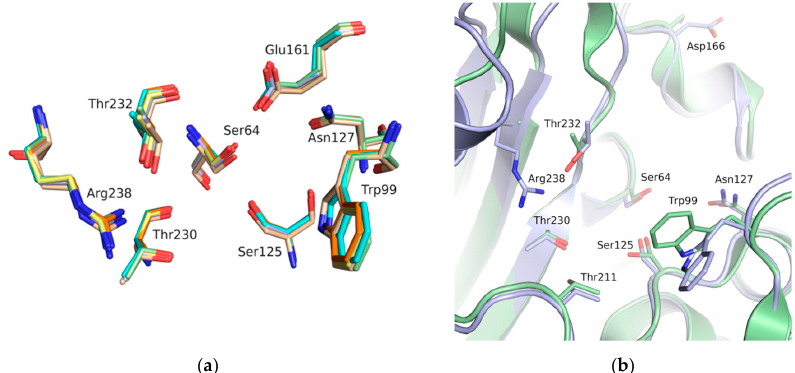
Figure 3. ( a ) Alignment of binding site residues of available GES-5 structures (PDB 6TS9, green; PDB code 6Q35, beige; 4GNU, blue; 4H8R, yellow; 5F82, cyan; 5F83, orange). ( b ) Alignment of the binding sites of GES-5 (blue, PDB code 6TS9) and KPC-2 (green, PDB code 3RXW) The residue numbering is for GES-5.